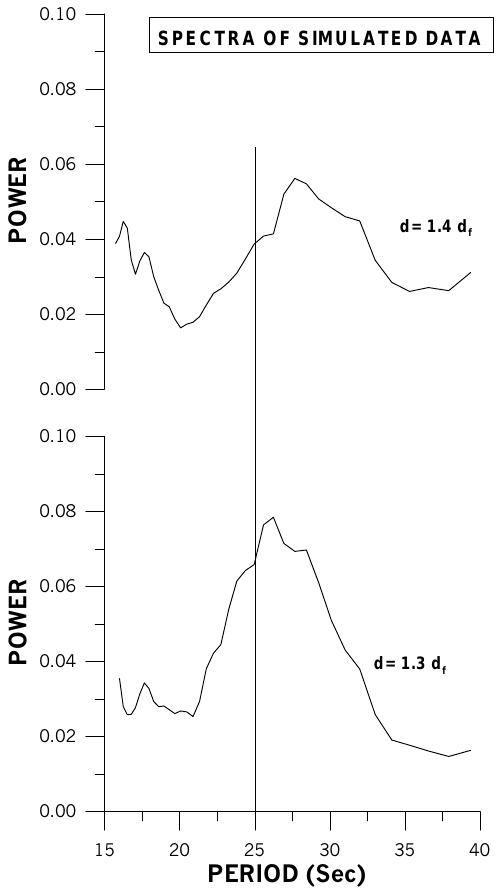
Fig. 11. Power spectrum of the numerically simulated scintillation data at a 2 s sampling interval. The plot has been shown for d > d f . The lower panel shows the spectrum for d = 1 . 3 d f and the upper panel shows the same for d = 1 . 4 d f . The characteristic eigen- period, used for the nomerical calculation, has been marked by the vertical